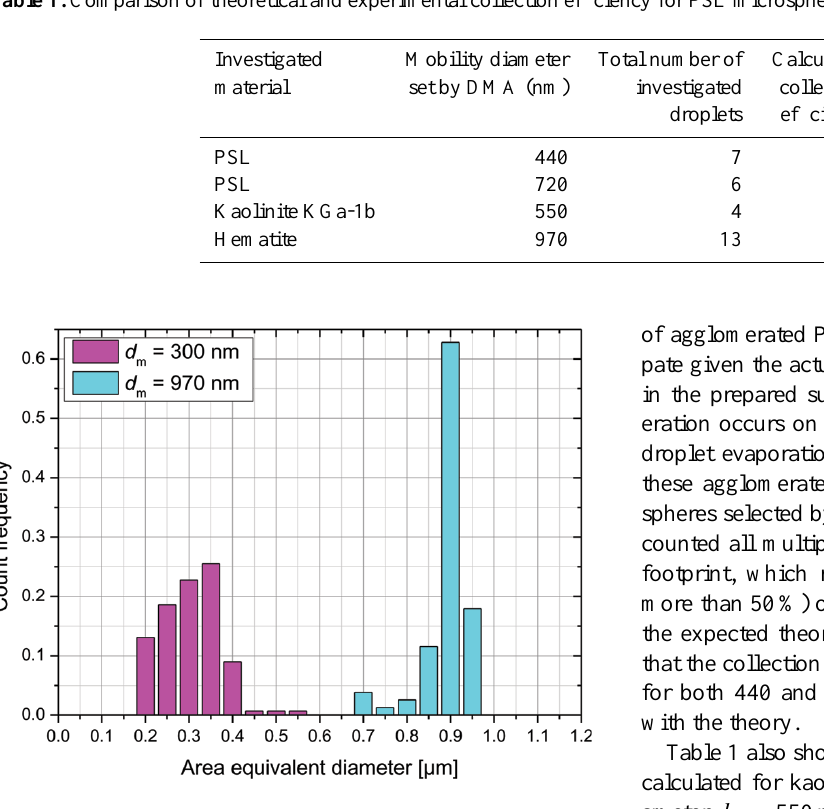
Fig. 6. Size distribution of hematite particles obtained from ESEM analysis of the projection